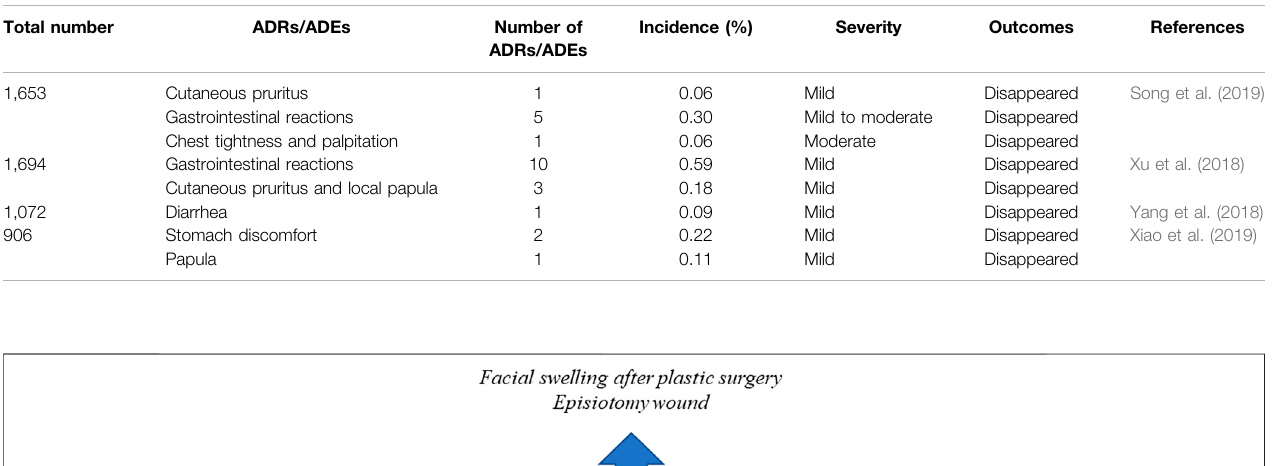
TABLE 4 | ADRs/ADEs of YNBY in a large number of patients.